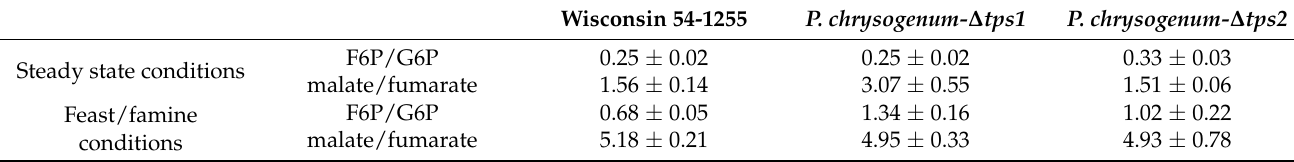
Table 2. Comparison of mass action ratios for phosphoglucose isomerase (PGI) and fumarase of different Penicillium chrysogenum strains obtained from both steady state conditions and feast/famine cultures at the average dilution rate of 0.05 h − 1 in the time range of 100–200 h of cultivation. Measurements are given as average ± standard deviation of at least two individual